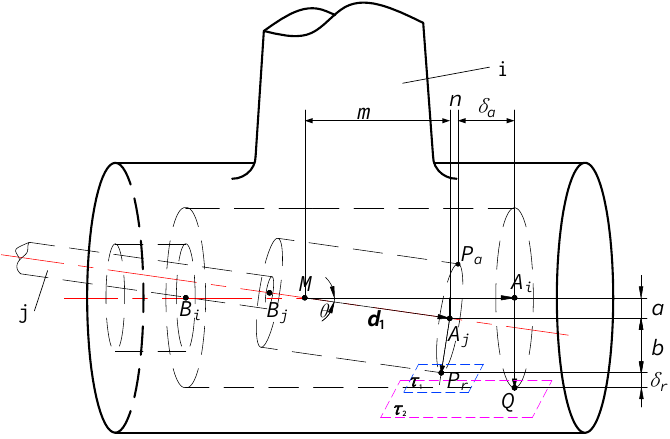
Figure 4. The axis of the bearing and journal is not parallel.